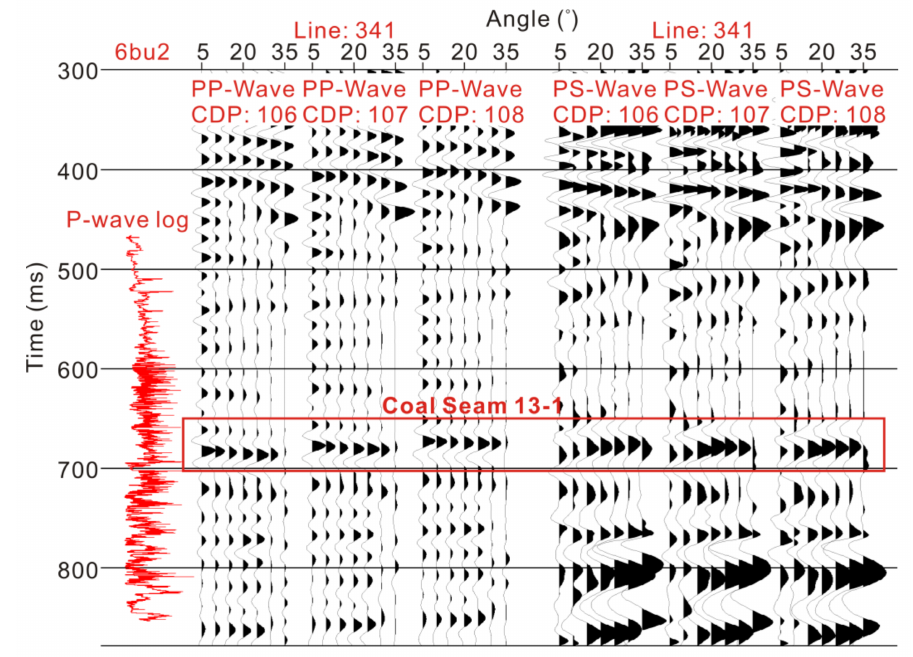
Figure 9. Time-aligned AVA gathers near well 6bu2 (line: 341, CDP: